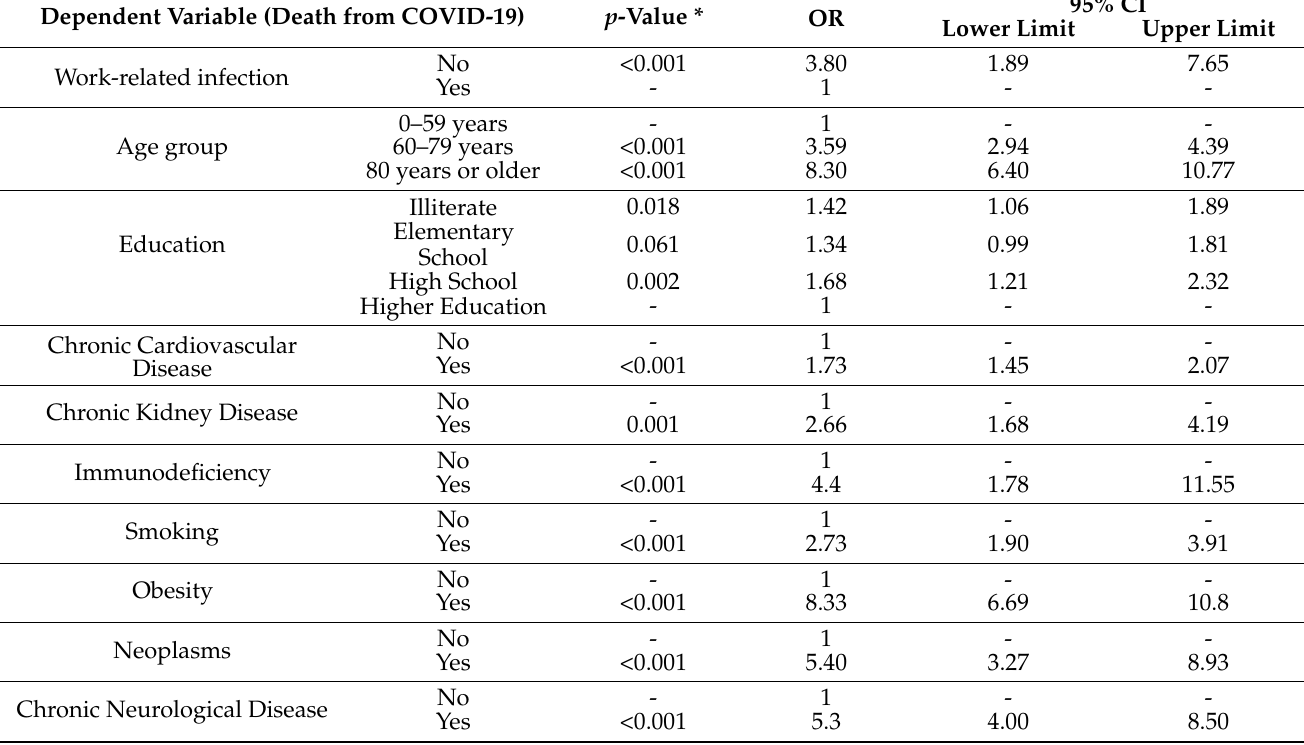
Table 2. Univariable survival for the outcome of death from COVID-19 (Kaplan Meier and Log-Rank test) in hospitalized patients in Esp í rito Santo, Brazil, in the period from 1 March 2020 to 31 July 2021.